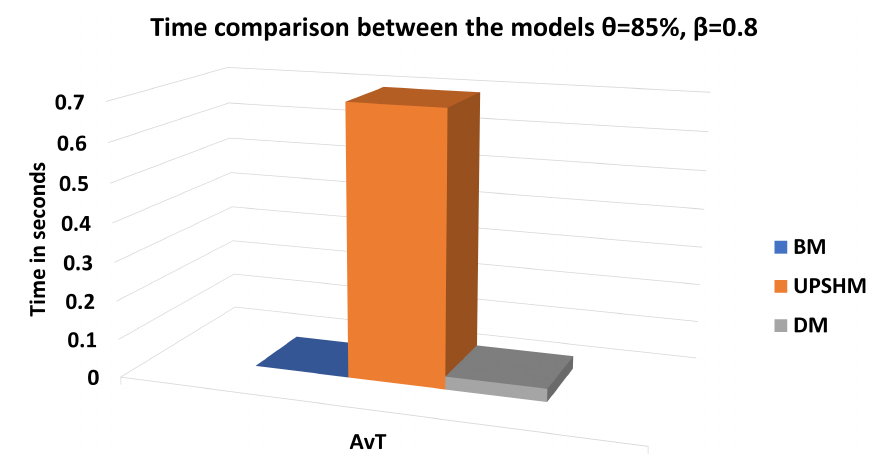
Figure 4. Time comparison between the models for θ = 85% and β = 0.8.